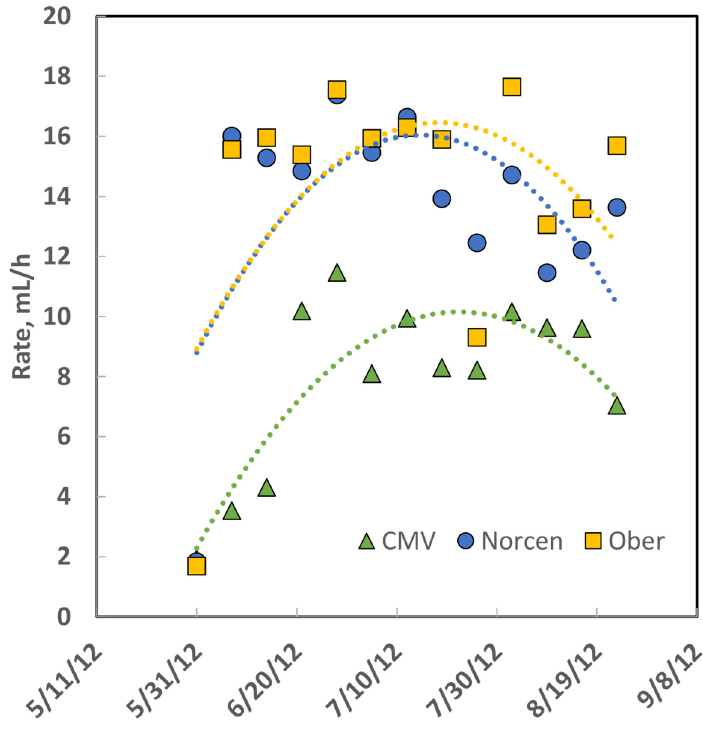
Figure 2. Rate constant data for gas production during in vitro forage fermentation of samples col- lected from rotationally stocked pre-grazing pastures in 2012; dates are formatted as month/day/year. Data were fitted with second-order polynomial equations, illustrating that the magnitude of fermentation rate constants of the two birdsfoot trefoil (BFT) cultivars were similar to each other and greater than cicer milkvetch (CMV).